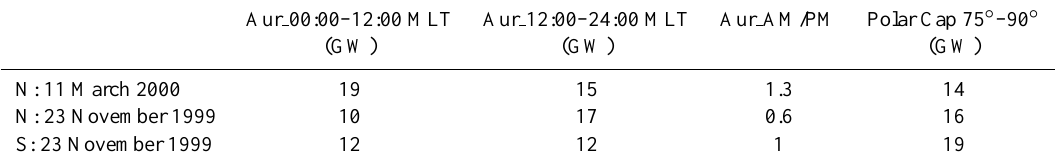
Figure 6 Fig. 6. Comparison of Northern Hemisphere DMSP F-13 data with Iridium/SuperDARN values for 23 November 1999. (top panels) DMSP F-13 and Iridium derived magnetic field values in north-south (left panel) and east-west (right panel) components. (lower panels) Poynting flux data along the DMSP track from 18.0 to 6.0 MLT (left panel) and a histogram of the differences in Poynting flux (right panel). Table 5. Total power in the auroral zone, divided into 00:00–12:00 (AM) and 12:00–24:00 (PM) local time ranges, and total polar cap power. Aur 00:00–12:00 MLT Aur 12:00–24:00